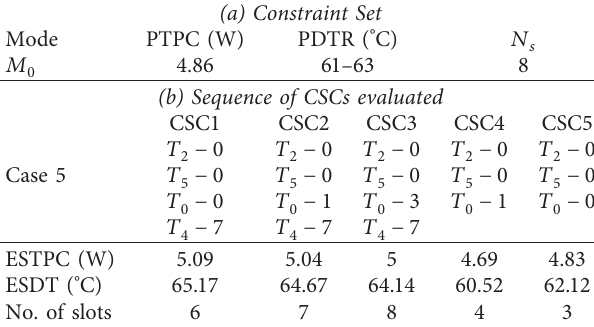
Table 9: Constraint Set and CSCs evaluated for case